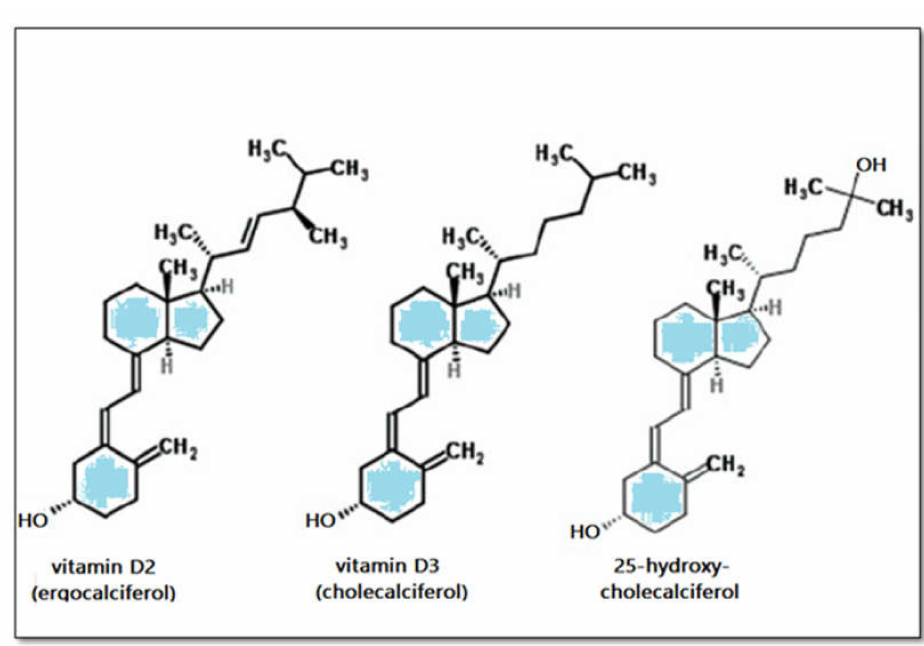
Figure 1. Vitamin D synthesis in the skin.